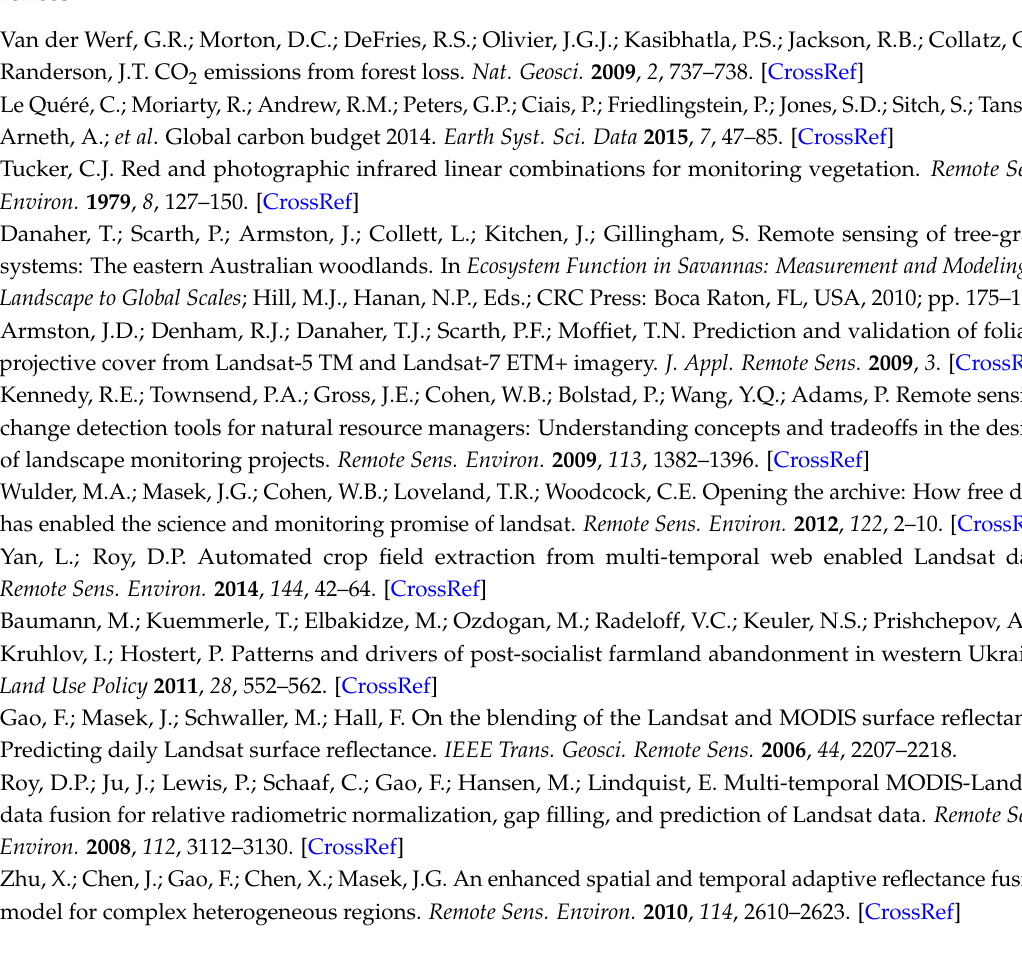
Figure A2. Color table for the STARFM and hybrid disturbance detection results.